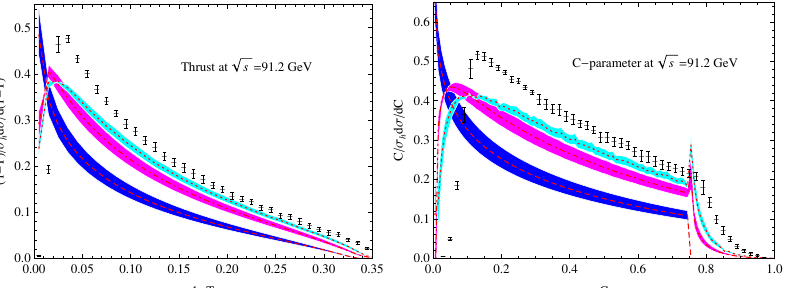
Figure 1. The thrust ( T ) and C -parameter ( C ) distributions using the conventional scale-setting √ s = 91.2 GeV, where the dashed, dot-dashed, and dotted lines are the conventional method at results at LO, NLO, and NNLO [45,48], respectively. The bands are obtained by varying the scale √ √ s /2,2 s ] . The experimental data are taken from the ALEPH Collaboration [39]. µ r ∈ [